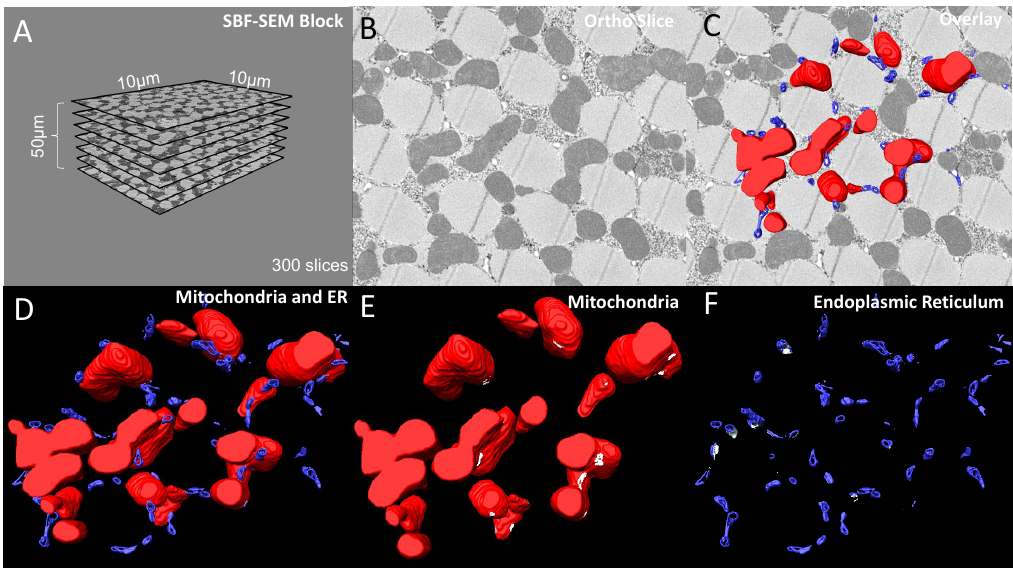
information on the volumetric spaces of the contacts between mitochondria (red) and ER (blue) (Figure 2D).